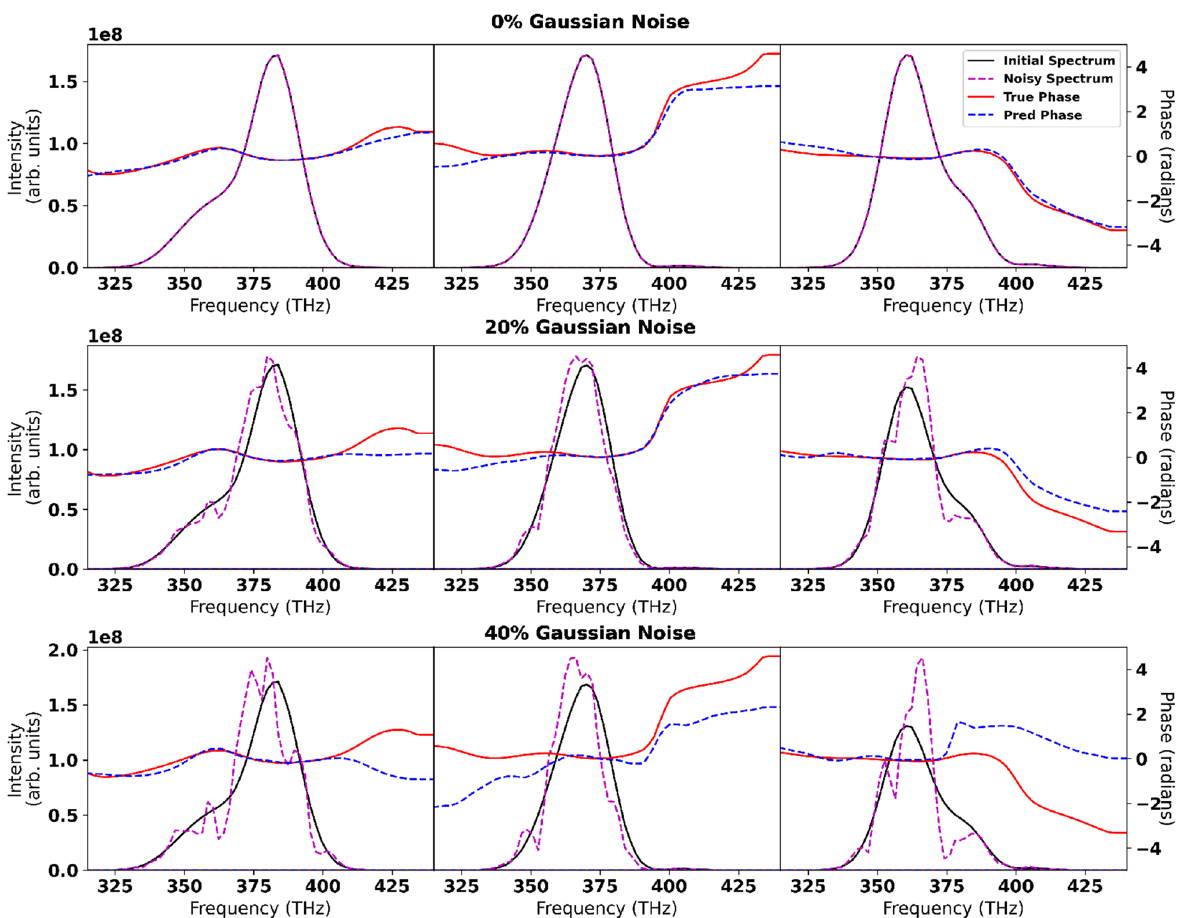
Figure 5. Reconstructions with Gaussian noise. To show the robustness of the phase predictions from the simulated few-cycle neural network above is three random initial spectra(black) and the noisy spectra(magenta) after adding a 0%, 20%, and 40% Gaussian noise. The true phase (solid red) is shown in comparison to the noisy phase (blue dashed) predicted from the noisy spectrum. The vertical dashed lines denote the location where the spectral intensity falls below 1% of the maximum value, outside this region the phase is